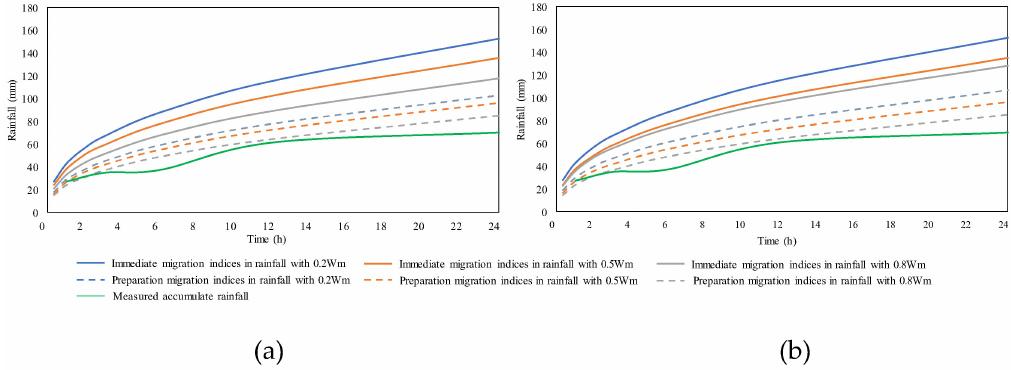
Figure 15. Accumulated rainfall curve for preparation and immediate migration and measured rainfall curve with different antecedent precipitation